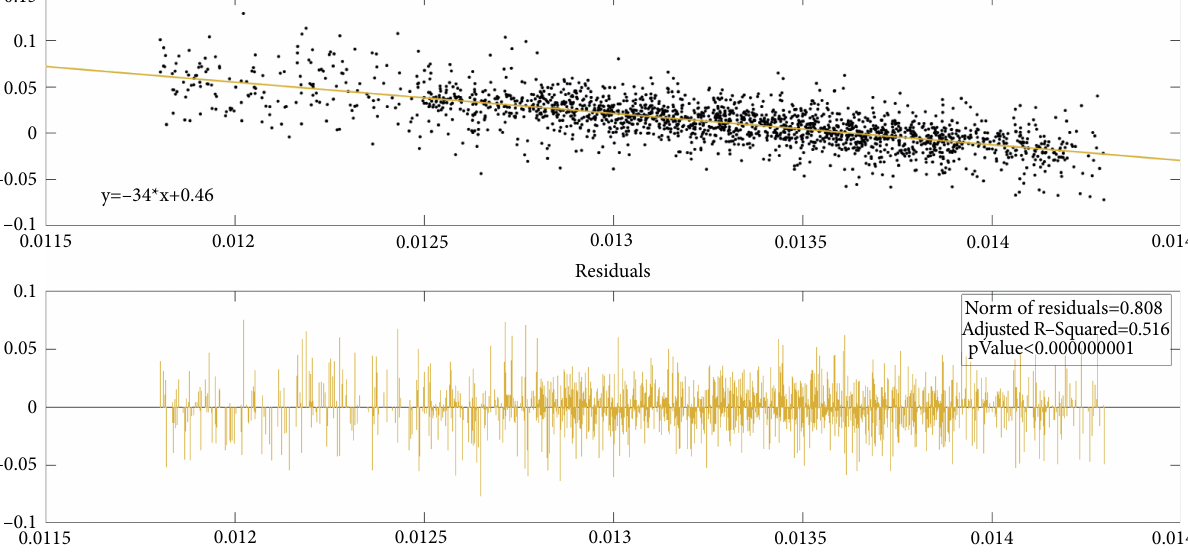
Figure 16: Change in potential ride-sharing utilization ( Y -axis), 2 hours prediction, as a function of the largest eigenvalue of the rides network ( X -axis), created for the last week of the